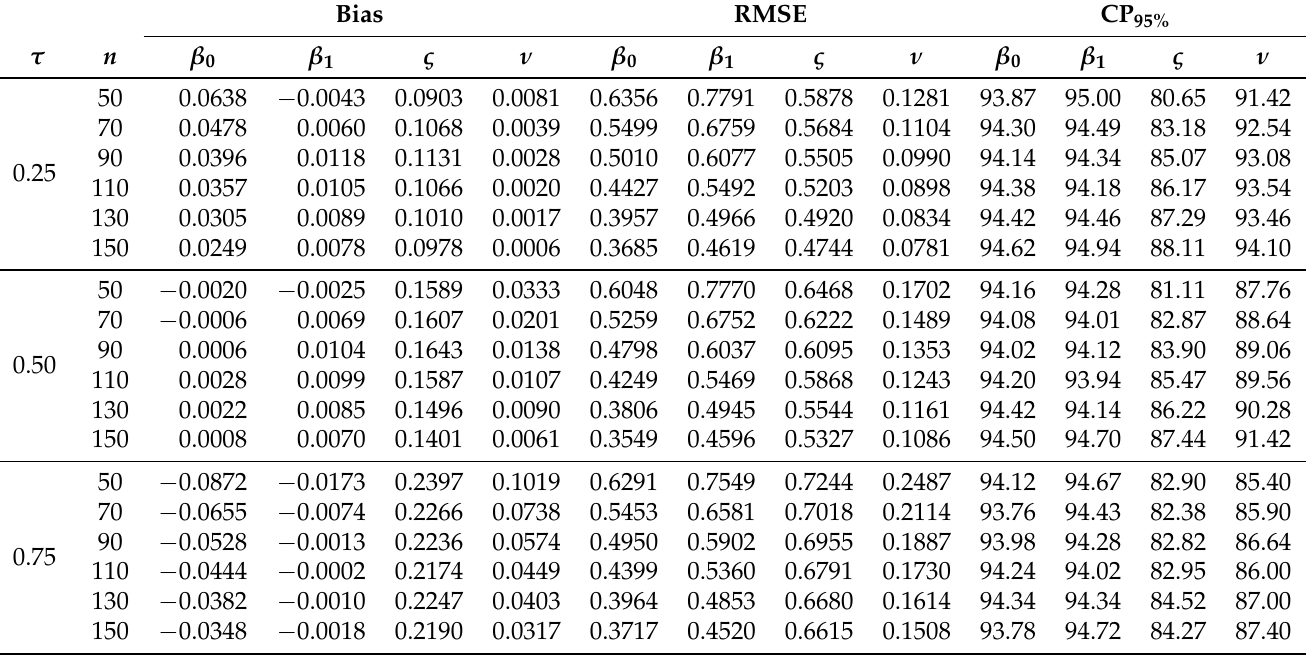
Table 2. Empirical RMSE, bias, and 95% CP (true values: β 0 = 0.50, β 1 = 0.50, ς = 0.50, and ν = 0.50) of the ML estimator for the indicated parameter with simulated